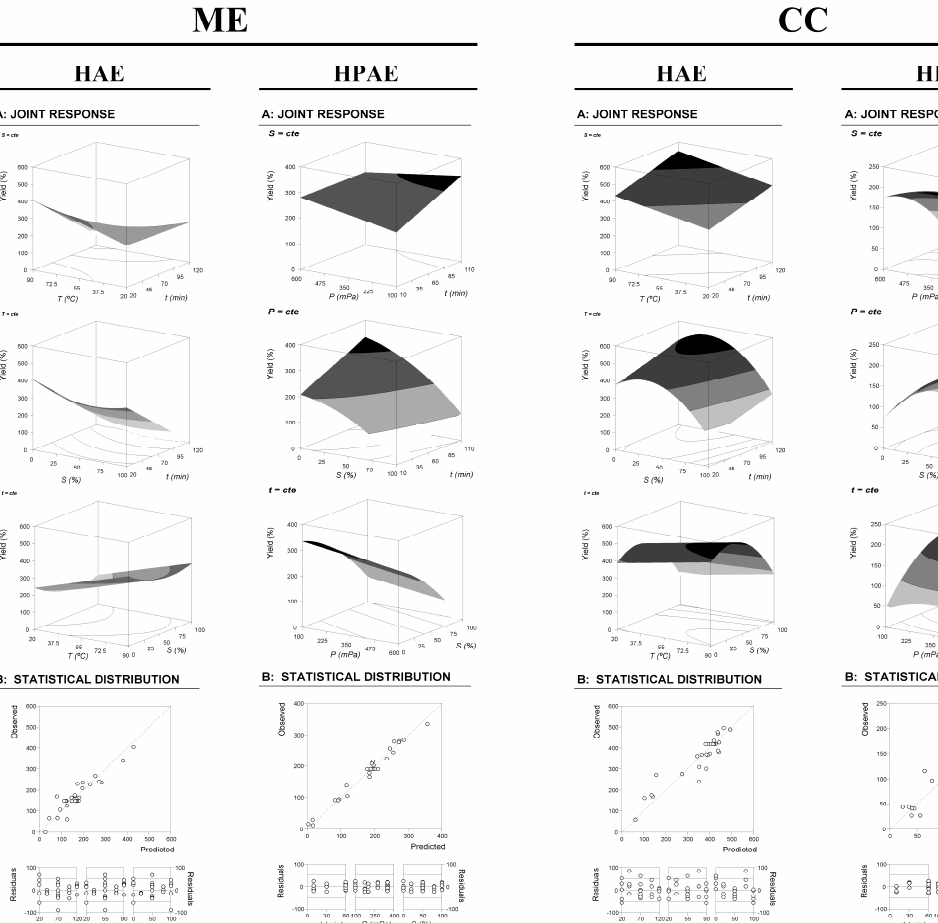
Figure 1. Graphical results in terms of the extraction yields of each alga ( Y ME , Y CC and Y GP ) for both HAE and HPAE. Each figure is divided into two columns: Part A: 3D graphs of the predicted response surface thanks to the second order polynomial of Equation (2) through the binary actions between two variables, when the excluded variable is placed in the individual optimal value (Table 6). Part B: To show the benefit of adjustment, two basic statistical criteria were used. On the one hand, the ability to simulate response changes between predicted and observed data; and on the other hand, the residual values distribution according to each one of the variables. Note to the values of the z axis corresponding to the yield (%) for HAE are constant (0–600), however, for the HPAE the axes vary according to the species of